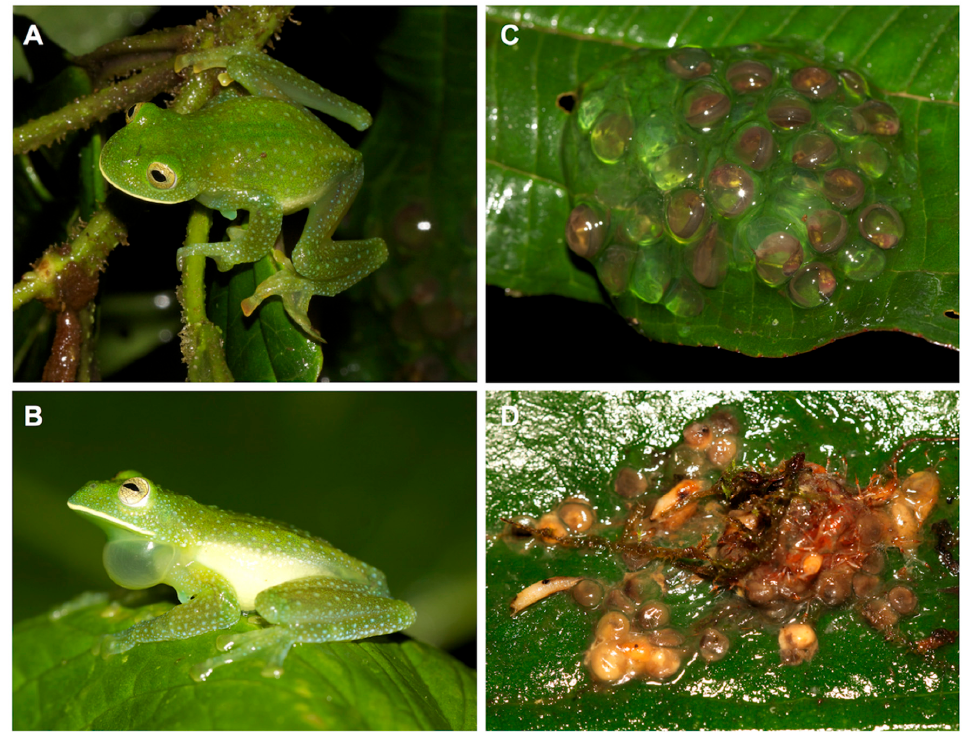
Figure 37. Centrolene heloderma from Reserva Las Gralarias, Ecuador. ( A , B ) Adult male. ( C ) Egg clutch. ( D ) Egg clutch parasitized by larvae of Drosophilidae fly. Photos by Jaime Culebras. Diagnosis: (1) Vomers lacking teeth; (2) snout subacuminate in dorsal profile, inclined anteriorly from nostrils to margin of lip in lateral profile (Figures 37, 38); (3) tympanum completely visible, oriented almost vertically, relatively large, its diameter 38.5%–44.5% of eye diameter; supratympanic fold moderate; tympanic membrane pigmented, clearly differentiated from surrounding skin; (4) dorsal surfaces of males and females pustular; in males, minute spicules evident only on flanks and tympanic region; (5) pair of enlarged subclocacal warts; (6) anterior three-fourths of ventral parietal peritoneum with white iridophores (condition P3); white pericardium; no iridophores in peritonea covering intestines, stomach, kidneys, testes, gall bladder, and urinary bladder (condition V1); (7) liver tetralobed, lacking iridophores (condition H0); (8) in males, humeral spines present; (9) webbing absent between Fingers I, II, and III; moderate webbing between Fingers III and IV; webbing formula III (2–2 1/2 ) — (1 2/3 –2 + ) IV (Figure 37); (10) webbing formula on foot: I (1 1/4 –1 1/2 ) — 2 II (1–1 + ) — (2 + –2 1/4 ) III (1–1 + ) — (2–2 + ) IV (2 + –2 1/2 ) — (1–1 1/4 ) V; (11) external ulnar fold evident, white; inner tarsal fold low, short; outer tarsal fold long, with low white tubercles; (12) concealed prepollex; in males, nuptial pad Type I; (13) Finger II slightly longer than Finger I (Finger I 91.0%–95.5% of Finger II); (14) disc of Finger III of moderate width, about 59.3%–74.2% of eye diameter; (15) in life, dorsum green with green to bluish white warts; upper lip white; bones green; (16) in preservative, dorsal surfaces dull lavender, sometimes with minute white or cream spots; (17) in life, iris yellow to pale golden yellow with fine black reticulations; (18) melanophores mostly absent from fingers and toes, except for some on Finger IV, and Toes IV and V; (19) males call from upper sides of leaves near streams; call short (133–188 ms, mean = 161 ms, SD = 15.4 ms), with two notes per call; notes strongly pulsed; dominant frequency at 4393–4823 (mean = 4682, SD = 104) Hz; (20) fighting behavior unknown; (21) egg placed on the upper surfaces of leaves; parental care unknown; (22) tadpoles unknown; (23) medium body size, male SVL 26.8–31.5 mm ( = 29.0, n = 17); in one female, SVL 32.3 mm.